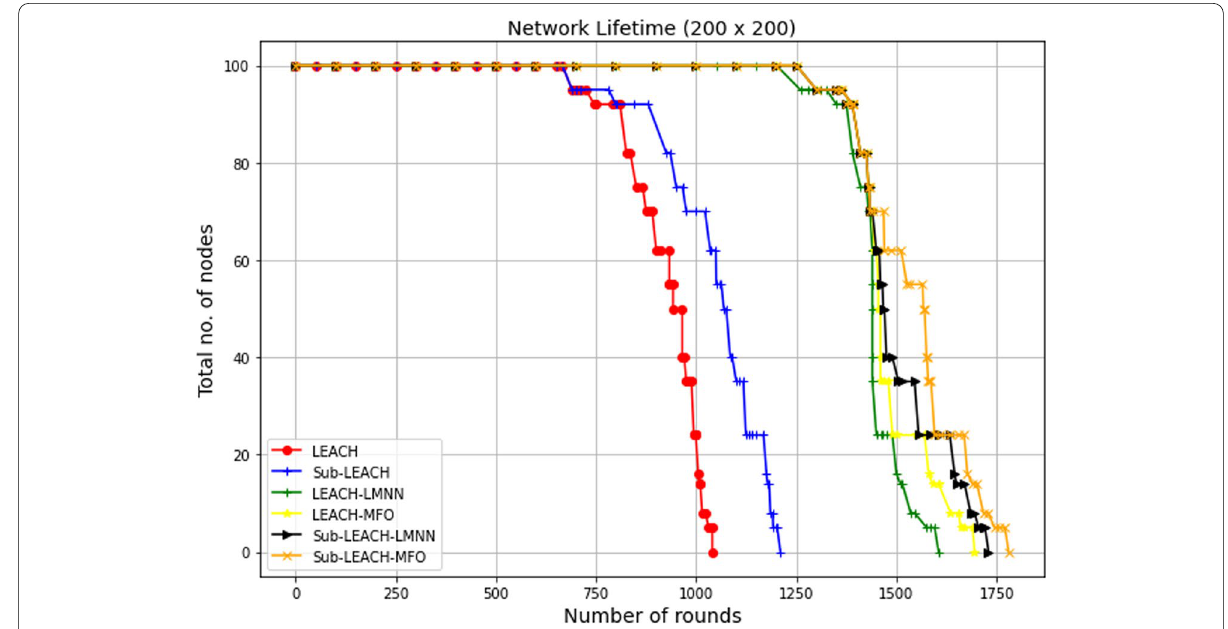
Fig. 10 Graphical representation of network lifetime for